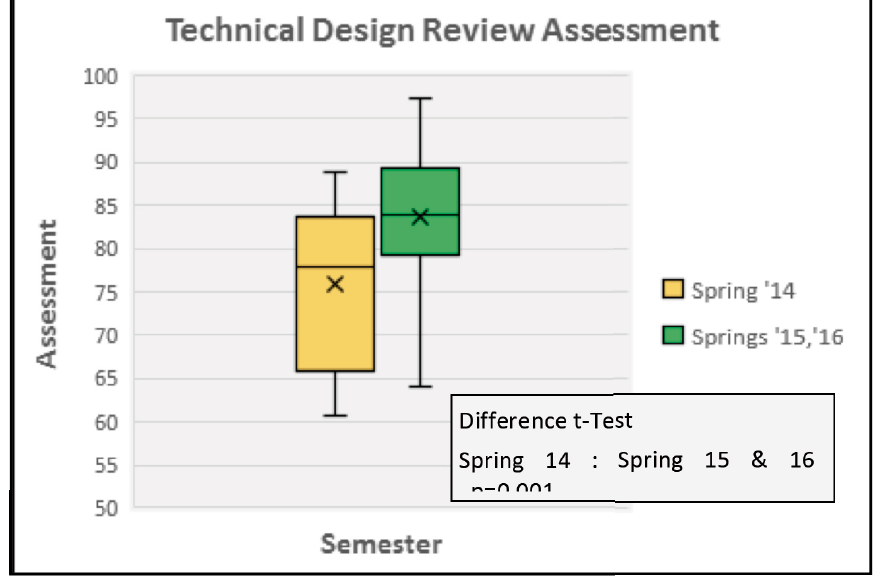
Fig. 6. Comparison of Technical Design Review Scores Before and After the Addition of an Earlier Feasibility